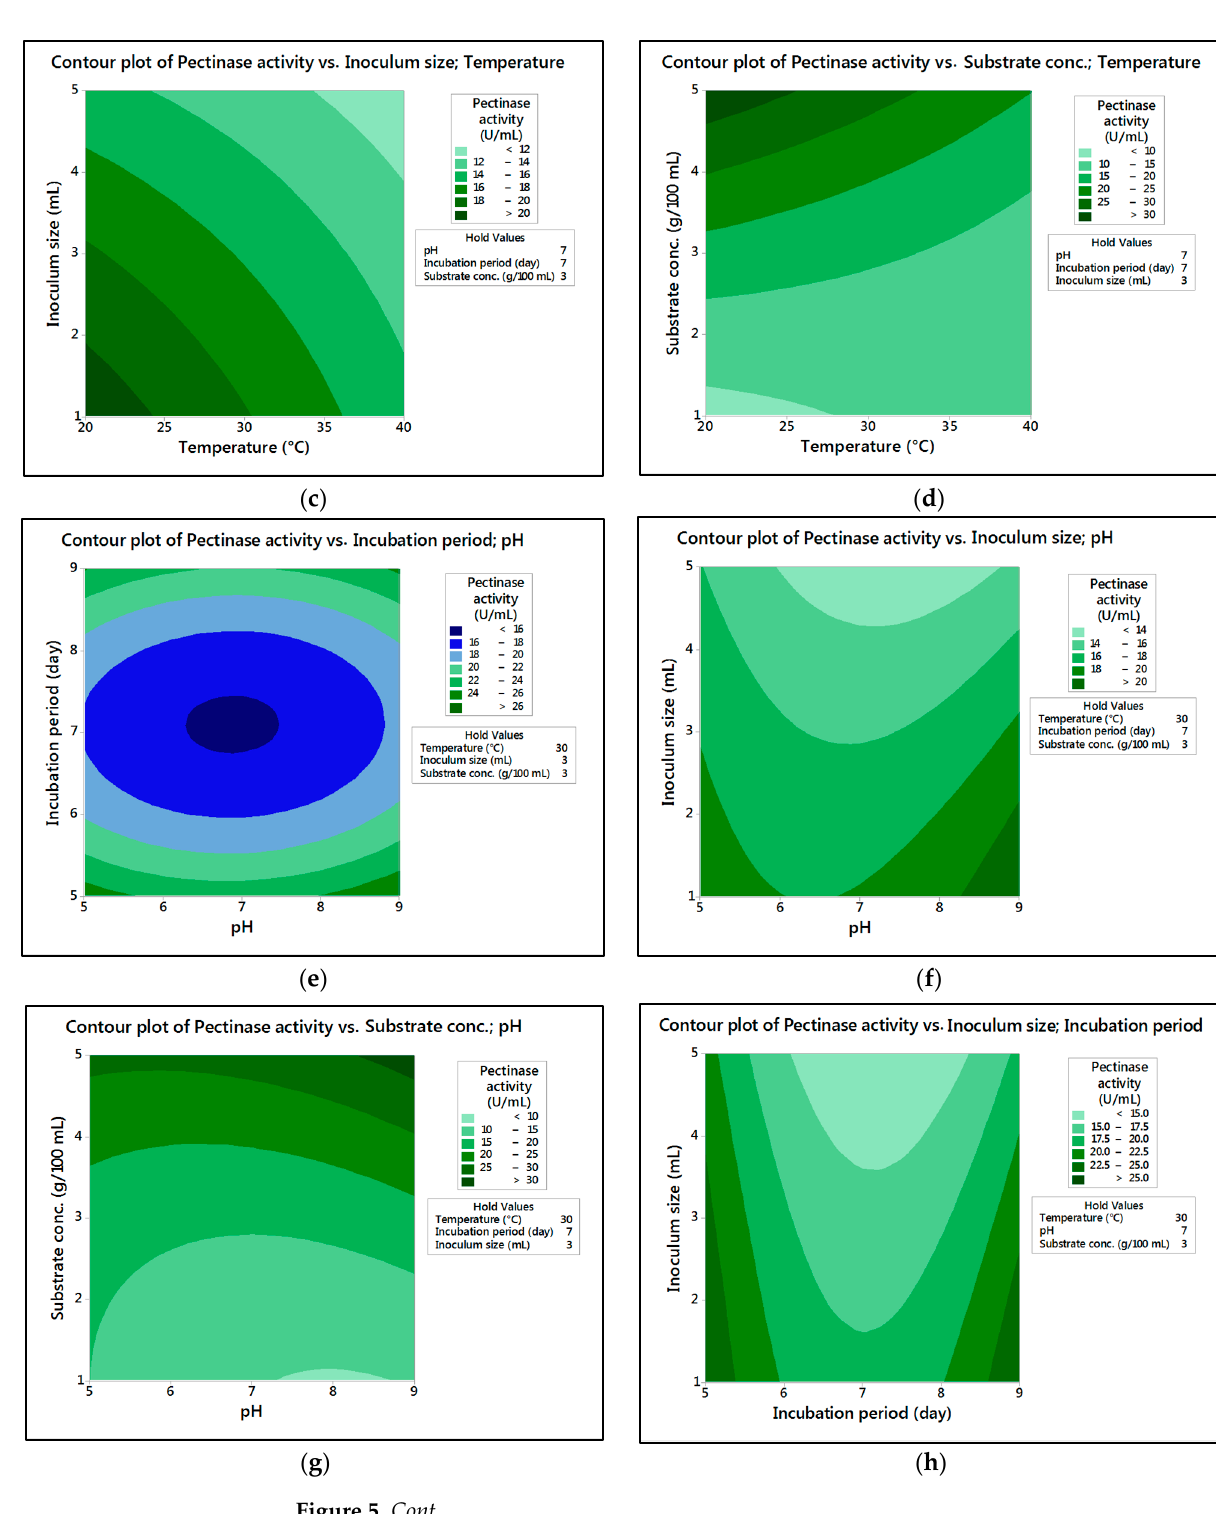
( j ) Figure 5. Contour plot showing interactions between independent variables: ( a ) incubation tem- perature with pH; ( b ) incubation temperature with incubation period; ( c ) incubation temperature with inoculum size; ( d ) incubation temperature with substrate concentration; ( e ) pH with incuba- tion period; ( f ) pH with inoculum size; ( g ) pH with substrate concentration; ( h ) incubation period with inoculum size; ( i ) incubation period with substrate concentration; ( j ) inoculum size with sub- strate concentration for pectinase activity produced by M. circinelloides . ( a )